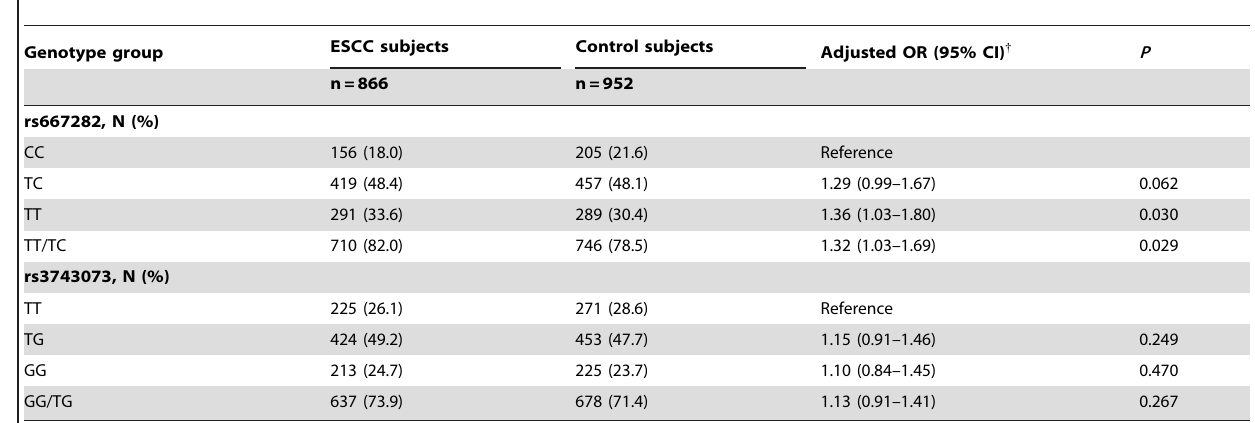
Table 2. The genotype distribution of 2 SNPs among cases and controls and their association with ESCC risk.